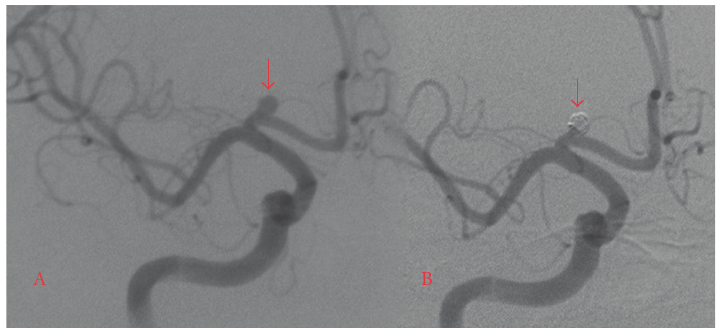
Figure 2: Preoperative DSA of a 4.1mm × 3.2 mm ACOM aneurysm. This specific UIA was chosen for endovascular treatment due to enlargement and visual field deficits. (b) Postoperative DSA. Endovascular coiling produced near complete occlusion.